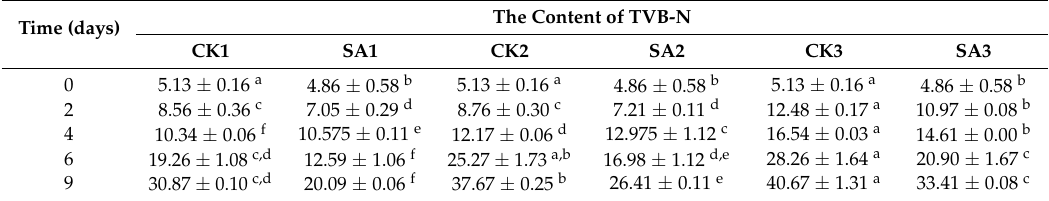
Figure 4. Effect of CFS from A. sobria on TVB-N content of Pacific white shrimp ( L. vannamei ) during different cold chain logistics. Table 3. Effect of CFS from A. sobria on TVB-N content of Pacific white shrimp ( L. vannamei ) during different cold chain logistics by F test.